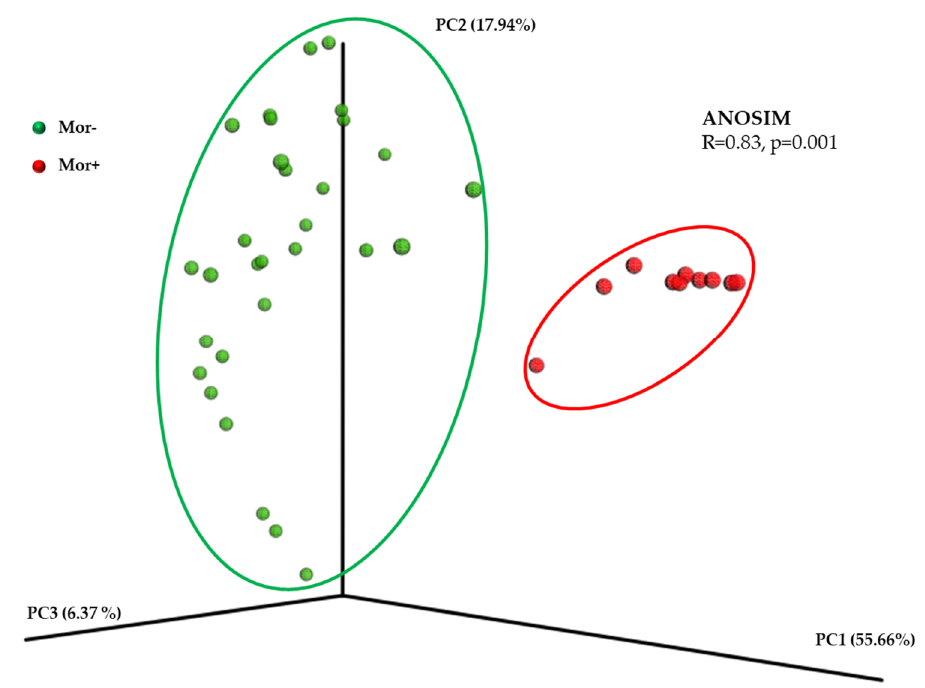
Figure 1. Principal coordinate analyses (PCoA) plot made using the normalized weighted UniFrac distance metric. Each dot corresponds to a single subject belonging either to Mor− (green dot) or Mor+ (red dot). The variance explained by each axis is given in parentheses. Dissimilarity between group was statistically tested applying the ANOSIM method.